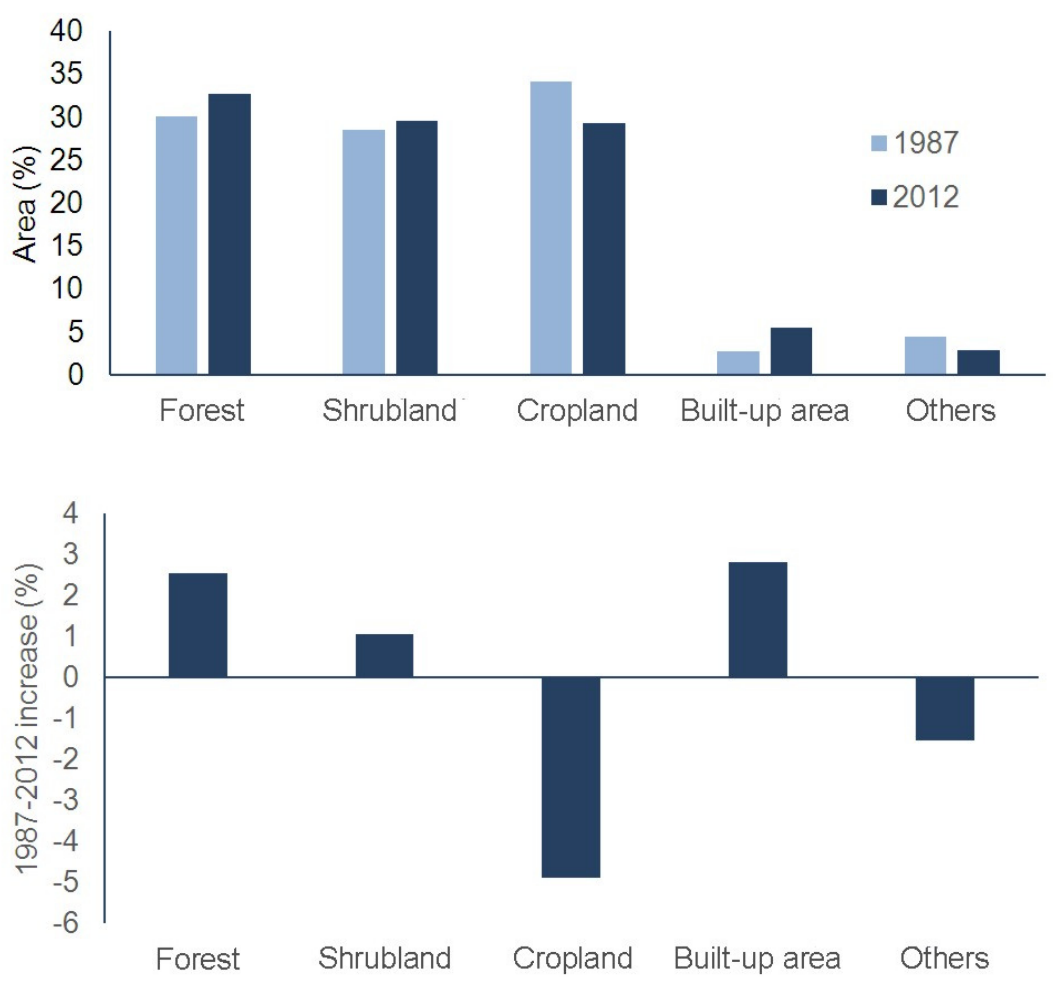
Figure 5. Percentage of the main types of land cover in Catalonia in 1987 and 2012 and increase (as a percentage with respect to the total territory) between these years. Source: ICGC-CREAF/UAB.